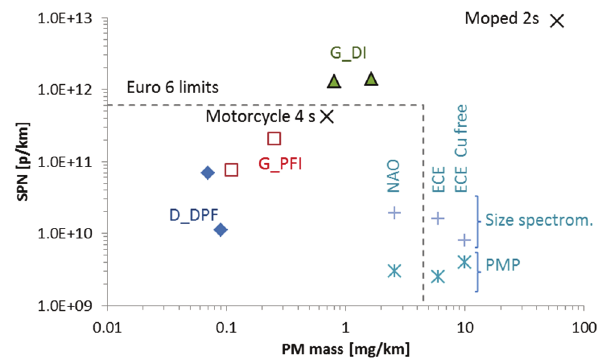
Fig. 10. PM mass and SPN measurements from a dilution tunnel using series-production pads from European market (ECE) and of non-asbestos organic (NAO) type (US market) with or without copper (Cu free). Results from [66, 67]. Results from exhaust emissions of various vehicles is also given for comparison